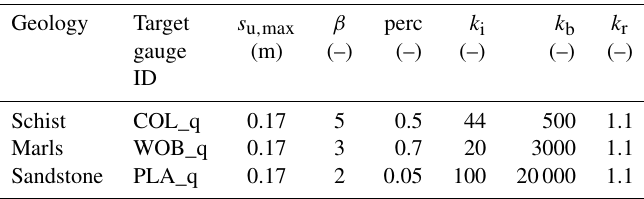
Table A3. Parameters of the SHM Attert found by calibration in the period of 1 November 2011 00:00–31 October 2015 23:00. All time references are given in CET. The parameters are described in Table A1.